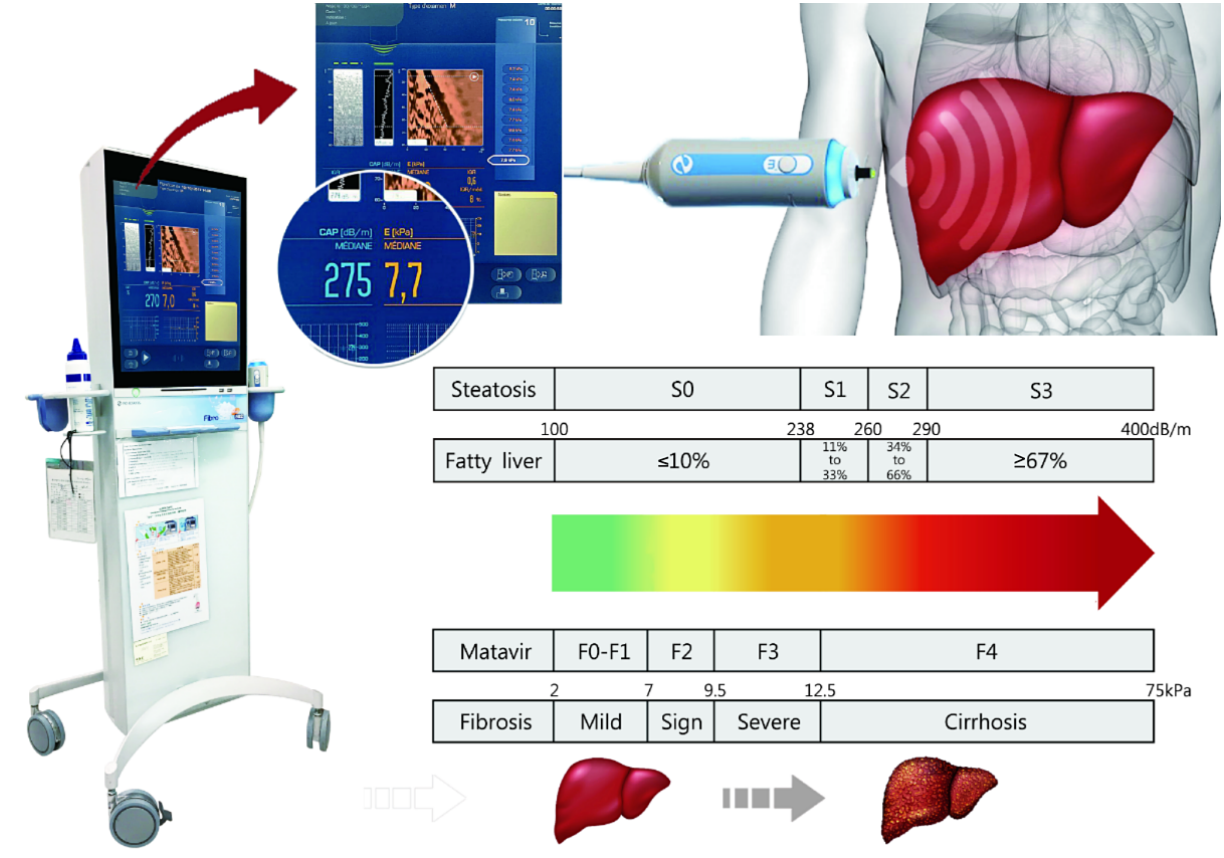
Figure 1. Illustration of the FibroScan device: liver diagnosis by ultrasound-based elastography. FibroScan measures fibrosis and steatosis in the liver. Measurements are performed by scanning the right liver lobe through the right intercostal space. The fibrosis result is measured in kiloPascals (kPa), and is normally between 2.5 and 6 kPa; the highest possible result is 75 kPa. Fibrosis score: F0 to F1, no liver scarring or mild liver scarring; F2, moderate liver scarring; F3, severe liver scarring; F4, advanced liver scarring (cirrhosis). The steatosis result is measured in decibels per meter (dB/m), and is normally between 100 and 400 dB/m. Steatosis can be graded from S0 to S3, corresponding to the severity of fatty liver from "0-10%" to "67% or